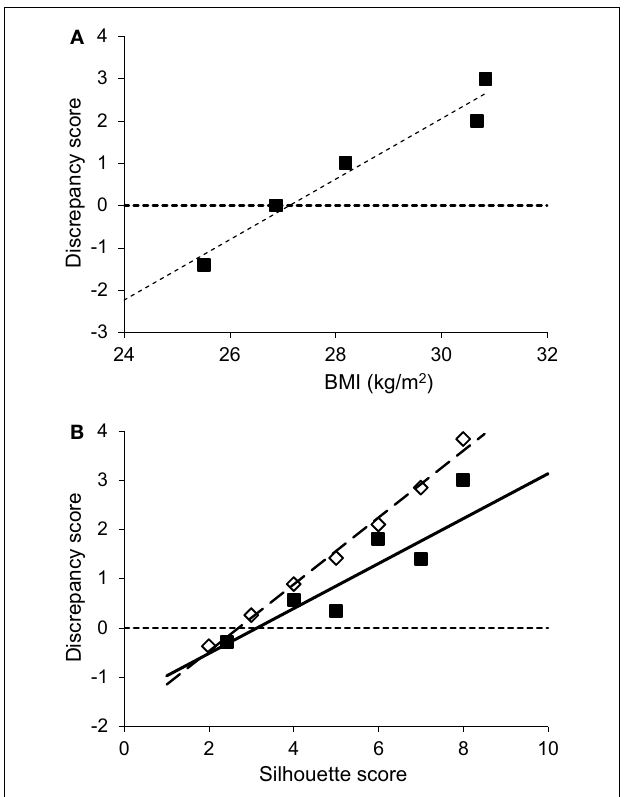
FIGURE 3 | Discrepancy between current and ideal body shape from body shape silhouettes . (A) Discrepancy (current minus ideal) silhouette score groups, shown according to the corresponding current mean BMI for that group (groups with scores 1 and 2 were small so were conflated), showing higher discrepancy scores correspond to higher BMI’s ( r = 0.37, intercept 26.9kg/m 2 , P < 0.01, n = 47). (B) Filled squares: discrepancy scores by current silhouette score where higher silhouette score indicates greater adiposity ( r = 0.61, P < 0.001, n = 47). Comparison is made with normative data (open diamonds) from a large Caucasian population ( n = 16,728) (41).